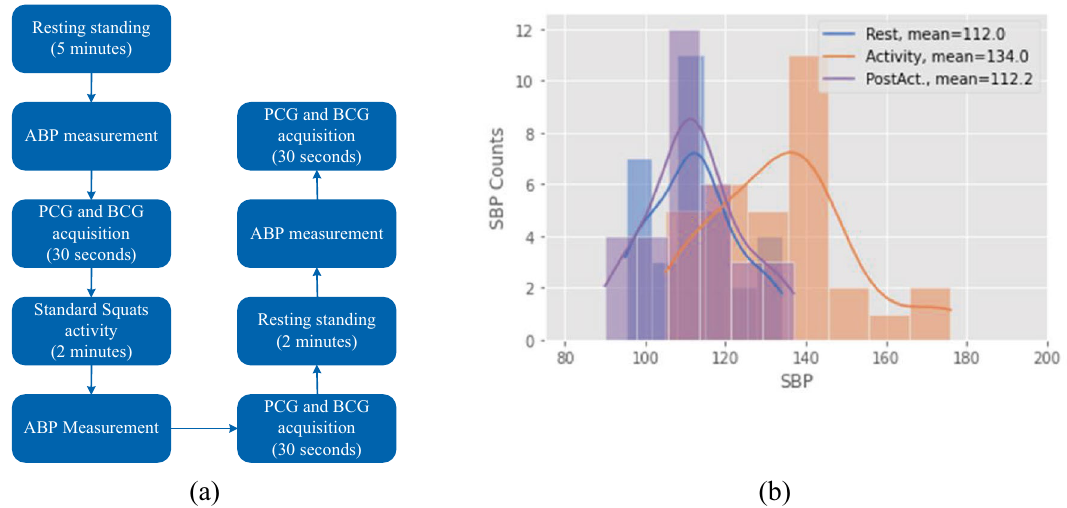
Figure 3. ( a ) Description of the measurement protocol. ( b ) Distribution of pressure measures related to each